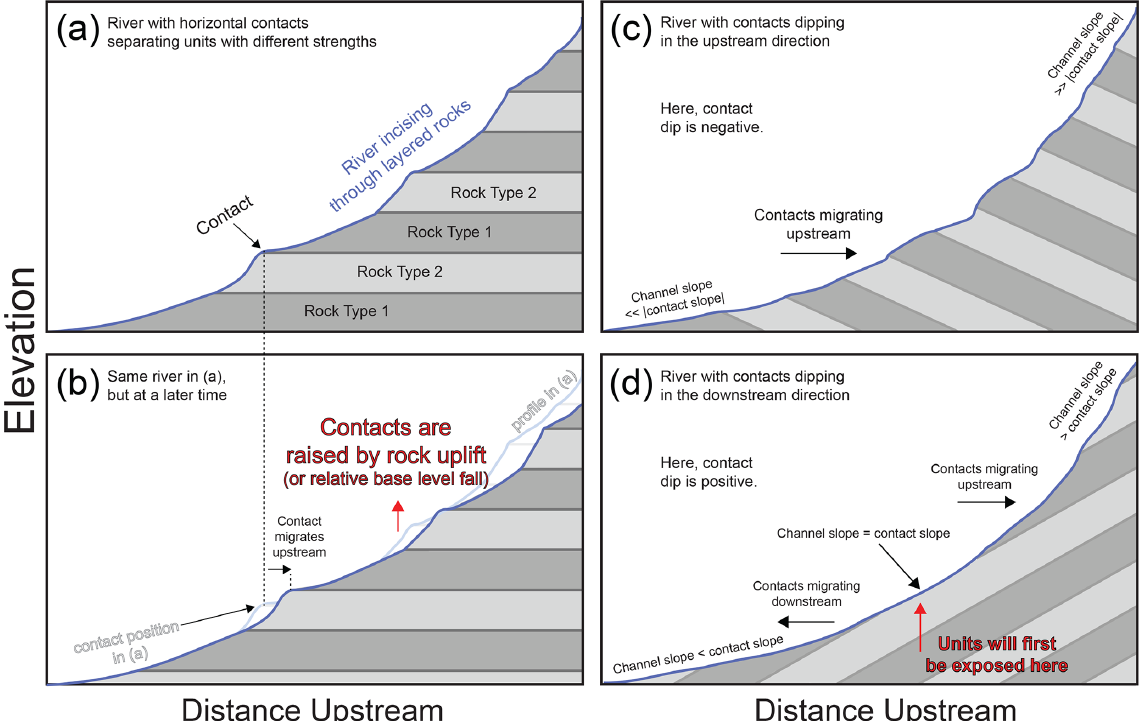
Figure 2. Conceptual models of bedrock river incision through layered stratigraphy. Here, only two rock types are shown: rock type 1 and rock type 2. Panels (a, b) show a river with a contact dip ( φ ) of 0 ◦ . Panel (b) is at a later time than panel (a) to demonstrate how the contacts gradually migrate upstream along the stream profile. Panel (c) shows a stream with contacts dipping in the upstream direction ( φ < 0 ◦ ). Panel (d) shows a stream with contacts dipping in the downstream direction ( φ > 0 ◦